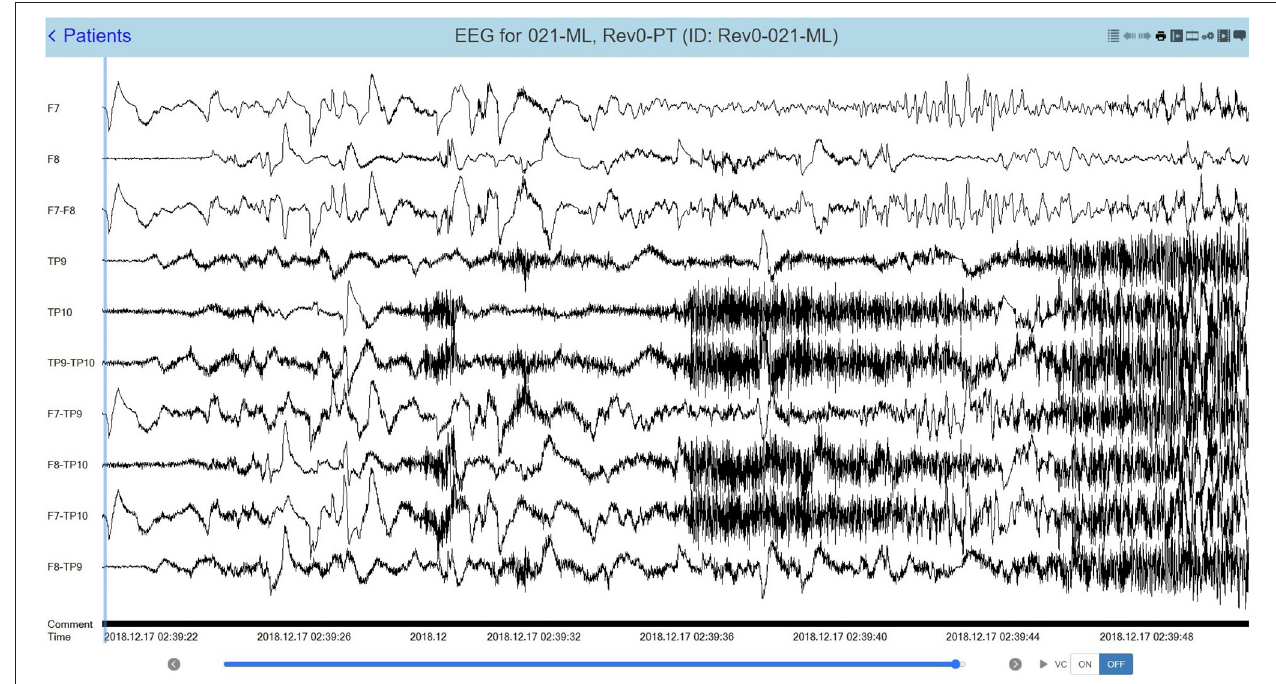
FIGURE 3 | A 30-s recording from four Epilog sensors during a focal-onset seizure evolving to bilateral tonic-clonic (TP10 focal onset), displayed in the 10-channel REMI montage.